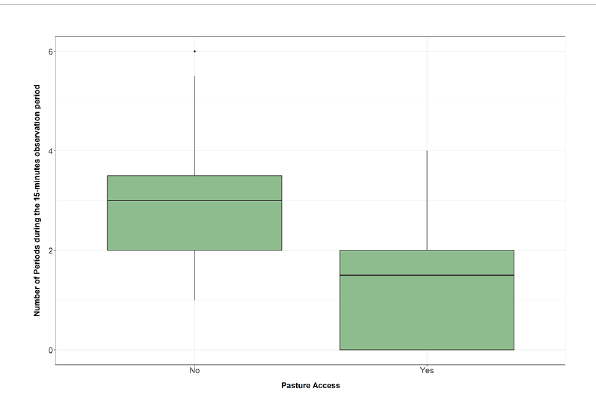
FIGURE 1 Distribution of the amount of the periods (AP) when the investigated cows showed stereotypic behavior within the 15 min of observation time depending on access to